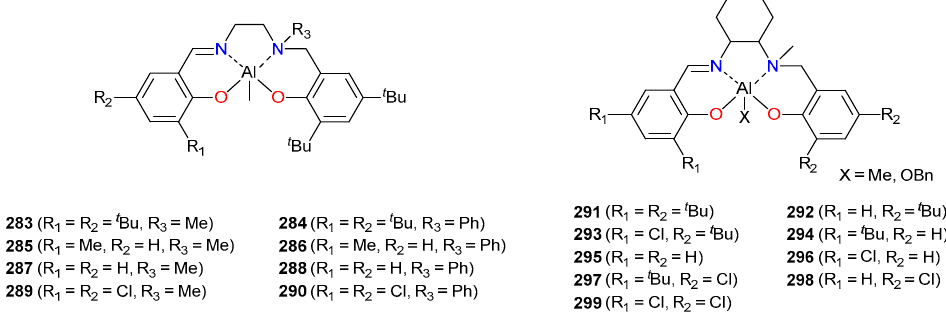
Figure 43. Salalen complexes active in the ROP of rac- lactide [125,126].